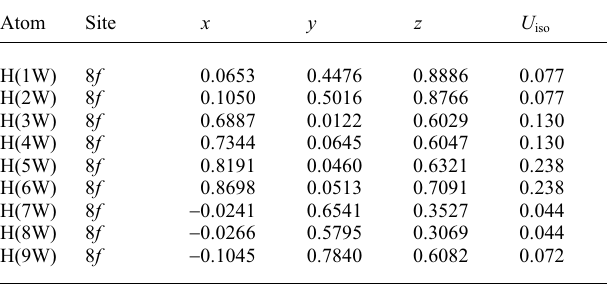
Table 2. Atomic coordinates and displacement parameters (in Å 2 ) .